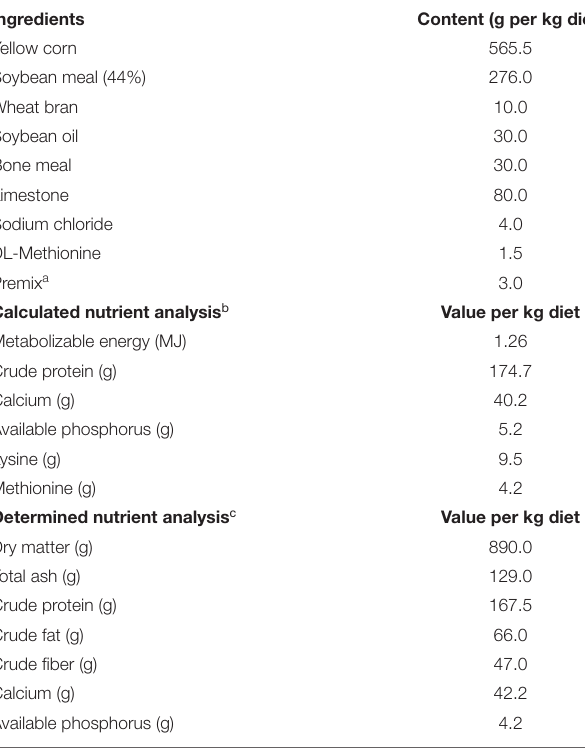
TABLE 2 | Effect of dietary organic selenium supplementation on the productive performance of laying hens under heat stress